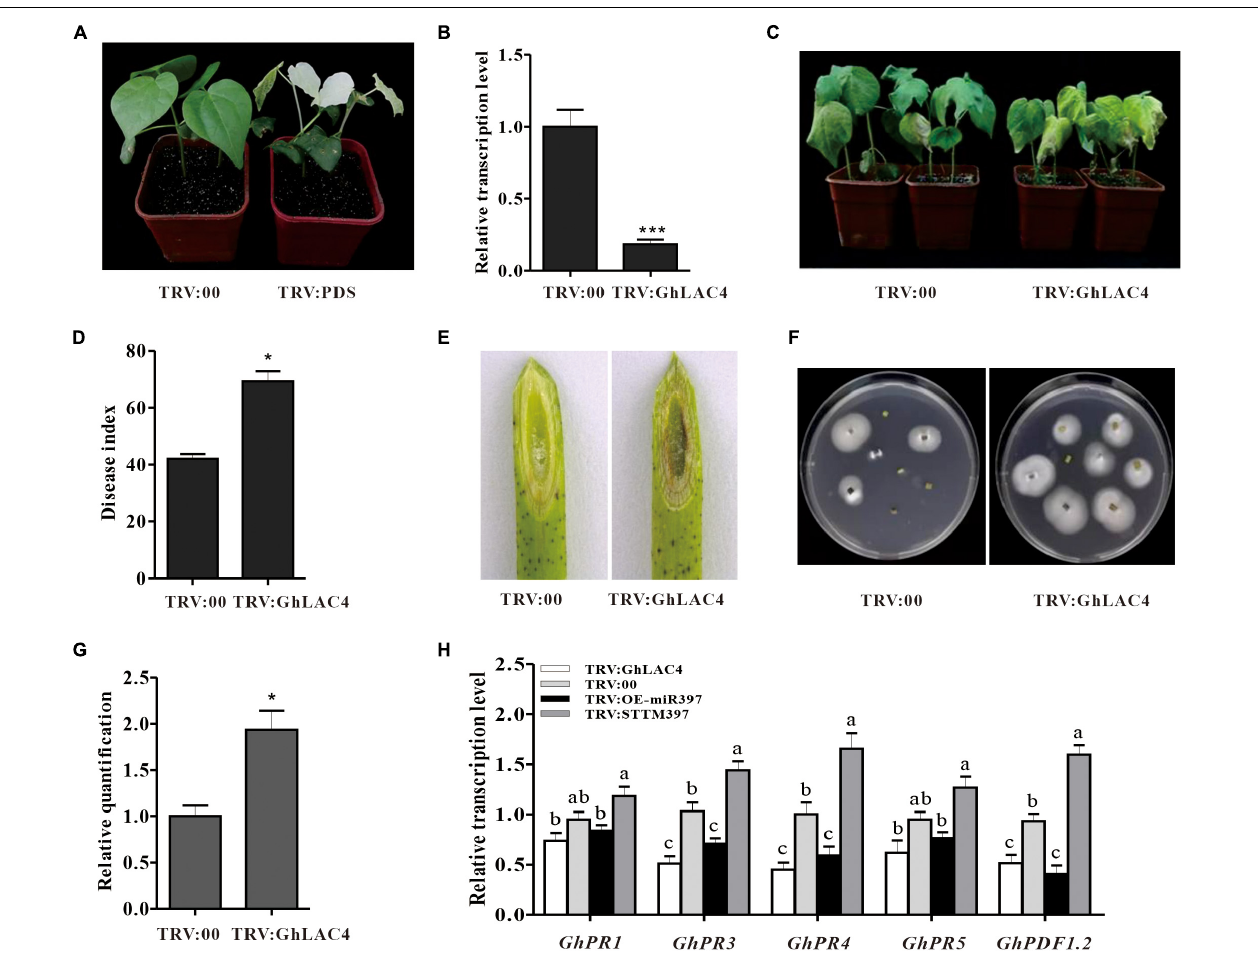
FIGURE 4 | The cotton miR397-LAC4 module mediated plant resistance to V. dahliae. (A) Photo-bleaching leaves of GhPDS -silenced plants. (B) Relative expression levels of GhLAC4 in the TRV: GhLAC4 plants compared to the TRV:00 plants. (C) Disease symptom of the TRV: GhLAC4 and TRV:00 plants inoculated with V. dahliae . (D) The disease index of the treated plants 21 dpi. (E) The brown colour of vascular tissue of plants 21 dpi. (F) Fungus recovery from 21 dpi stem fragments cultured for 5 days. (G) The V. dahliae biomass in the infested stems by qPCR. The DNA content of V. dahliae is relatively quantified through comparison of fungal β -tubulin gene and cotton UBQ7 gene. (H) Expression levels of the defence-related genes in TRV:STTM397, TRV:OE-miR397, TRV:GhLAC4, and the control plants inoculated with V. dahliae. GhUBQ7 was an internal reference gene. Mean with SD comes from triple repeats experiments. Significant differences in (B,D,G) were determined using Student’s t -test (* P < 0.05, *** P < 0.001). Different letters in (H) indicate significant difference ( P < 0.05) based on Tukey’s HSD test.